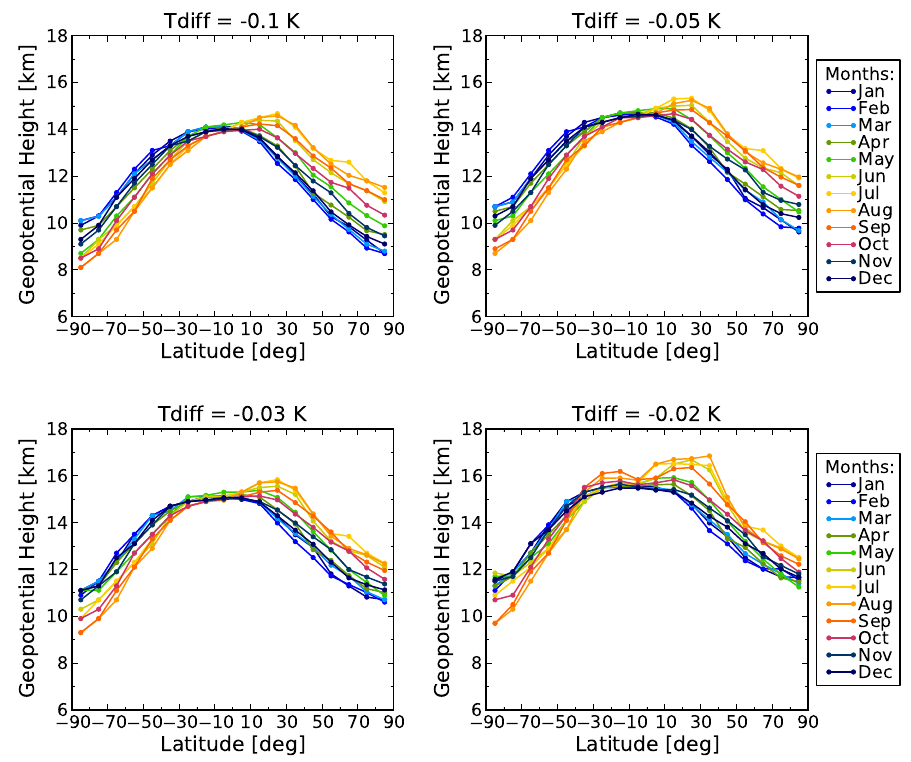
Figure 4. Calculated maxima (solid lines) from 2006 to 2010 of T diff = − 0 . 1, − 0 . 05, − 0 . 03, and − 0 . 02, for every month.